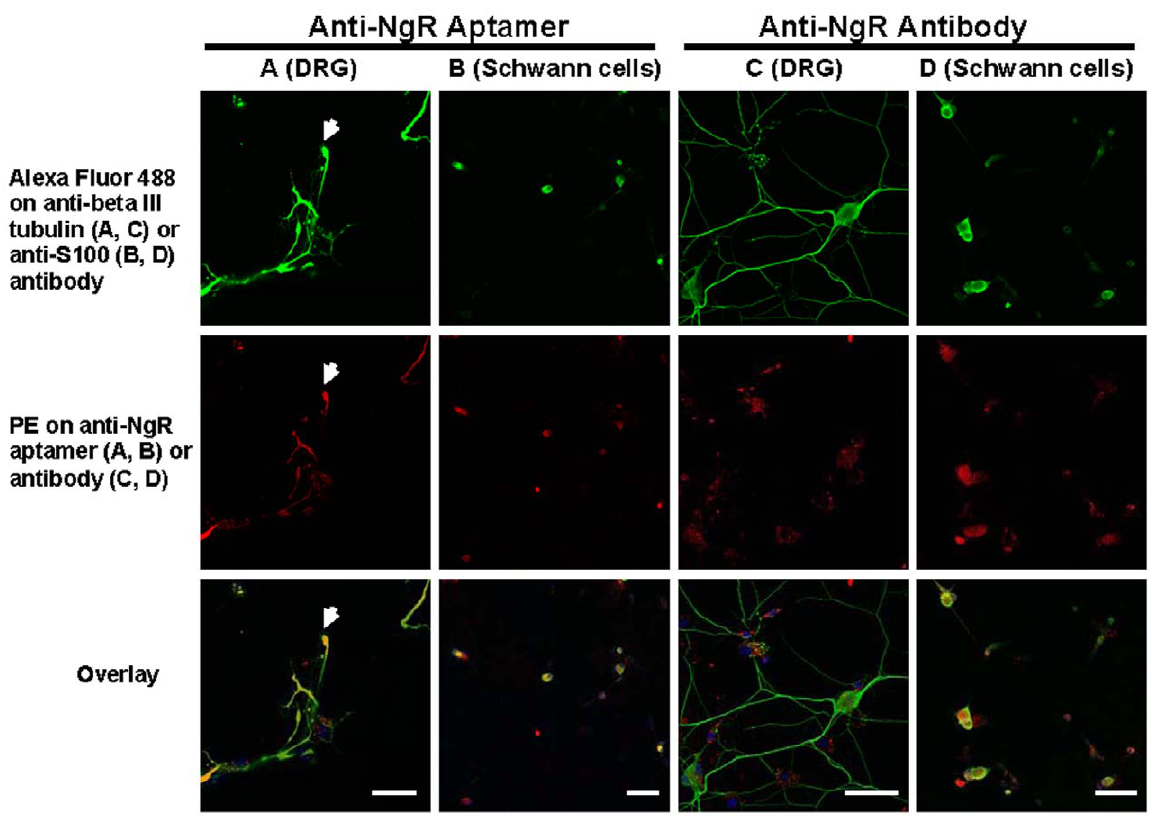
Figure 2. NgR expression in dorsal root ganglia and Schwann cells. DRG neurons in primary cultures were labeled using an anti-beta III tubulin antibody (green; columns A, C). Schwann cells were labeled using an anti-S100 antibody (green; columns B, D). Binding of a biotinylated anti- NgR aptamer (Clone 40) was detected with PE-labeled streptavidin (red; A, B). Binding of a biotinylated anti-NgR antibody was also detected with PE- labeled streptavidin (red; C, D). Yellow in the overlay indicates the overlap of green and red stains. Arrows in Column A indicate the position of a growth cone in a DRG neuron, and the overlay suggests localized expression of NgR. Scale bars: 25 m m (A); 50 m m (B-D).